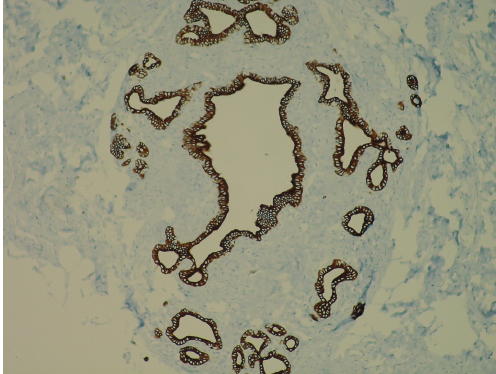
Figure 1: Lobular units with ductal structures in a fibrovascular tissue (x20).